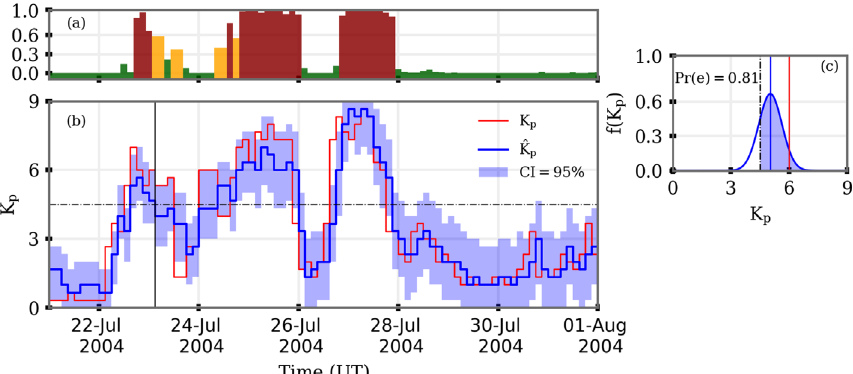
Fig. 9. Three-hour forecast (using l OMNI þ model) showing (a) probability of geomagnetic storms, (b) K p (22nd July – 31st July, 2004) and (c) an illustration of the method to extract probability of storm occurrence for one prediction marked by vertical black line in panel (b). Black dashed lines in panels (b) and (c) represent the threshold K p = 5 (cid:3) , red and blue thin lines in panel (c) are observed K p , and predicted mean respectively. Panel (b) is in the same format with Figure 7. The shaded region in panel (c) provides probability of geomagnetic storm (Pr[ e ] = 0.81, for details refer text).